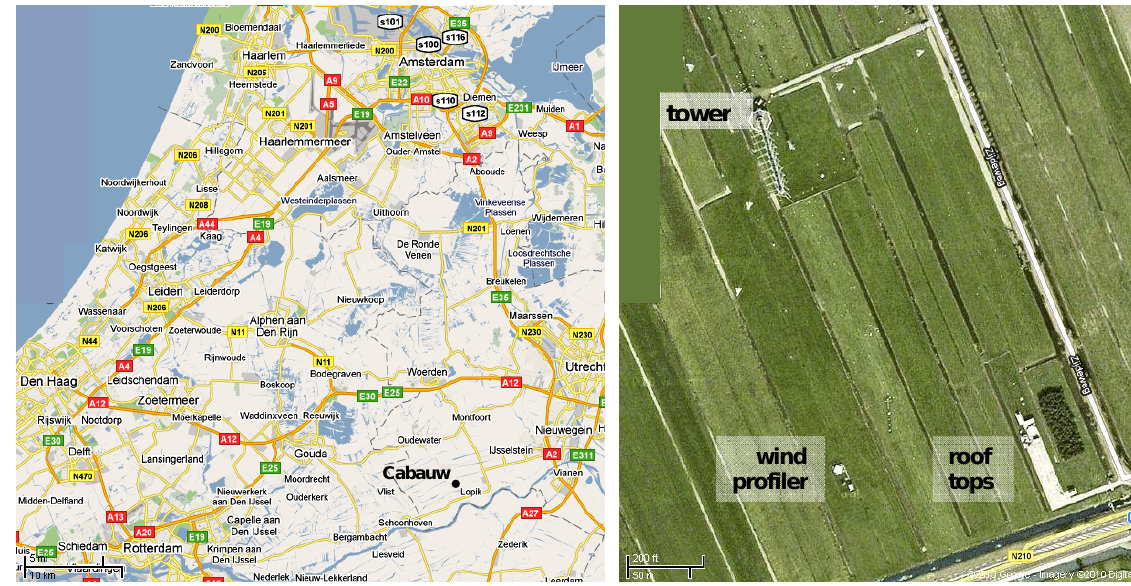
Fig. 2. Left: the site at Cabauw is located near Lopik in The Netherlands, 20 km SW of Utrecht. Right: the site has a tower, space for several containers with accessible roof tops, and another secure location at the wind profiler site.